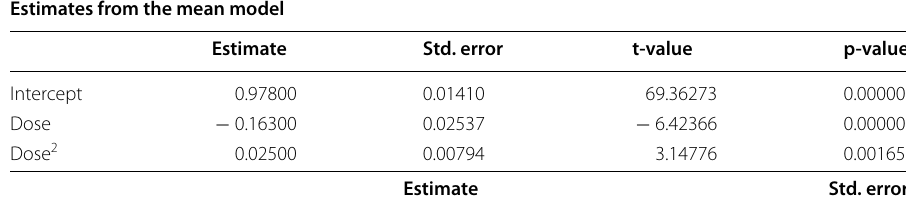
Table 4 Results for malformation model Estimates from the mean model